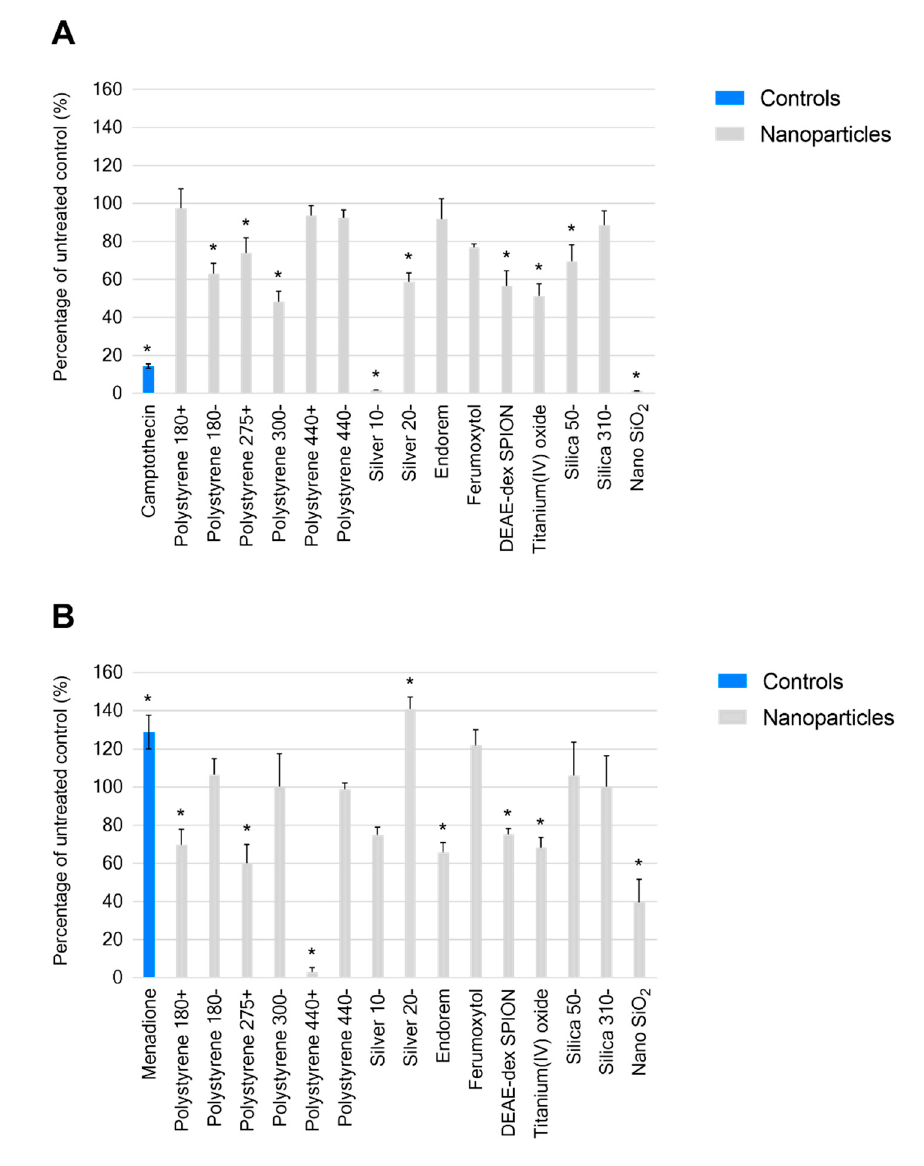
Figure 2. ( A ) Generation of reactive oxygen species, and ( B ) reduced glutathione in the presence of stated nanomaterials as a percentage of untreated of control. Data displayed as an average of four technical replicates ± standard deviation. * p -value < 0.05.